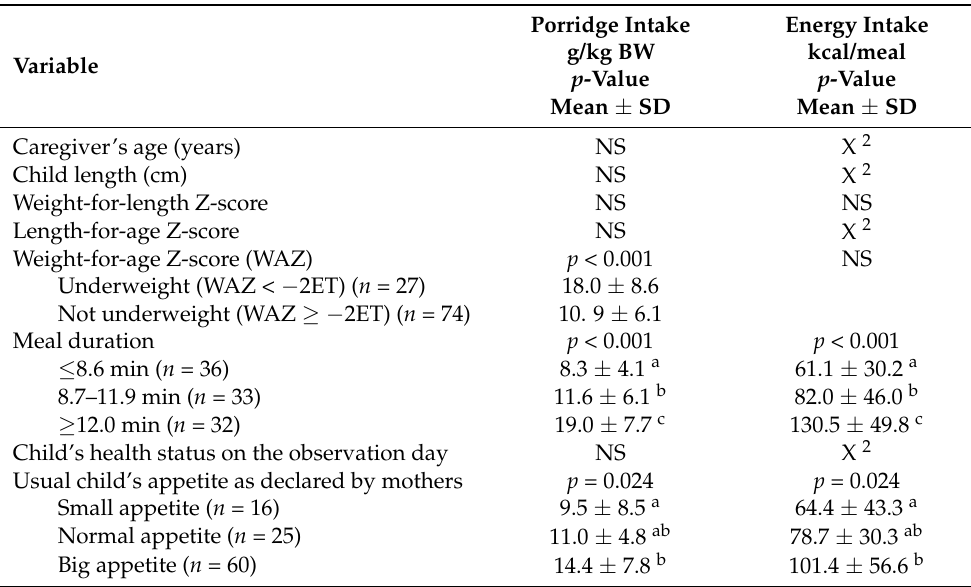
Table 6. Identification of variables with a significant effect on the children’s intakes: multivariate analysis 1